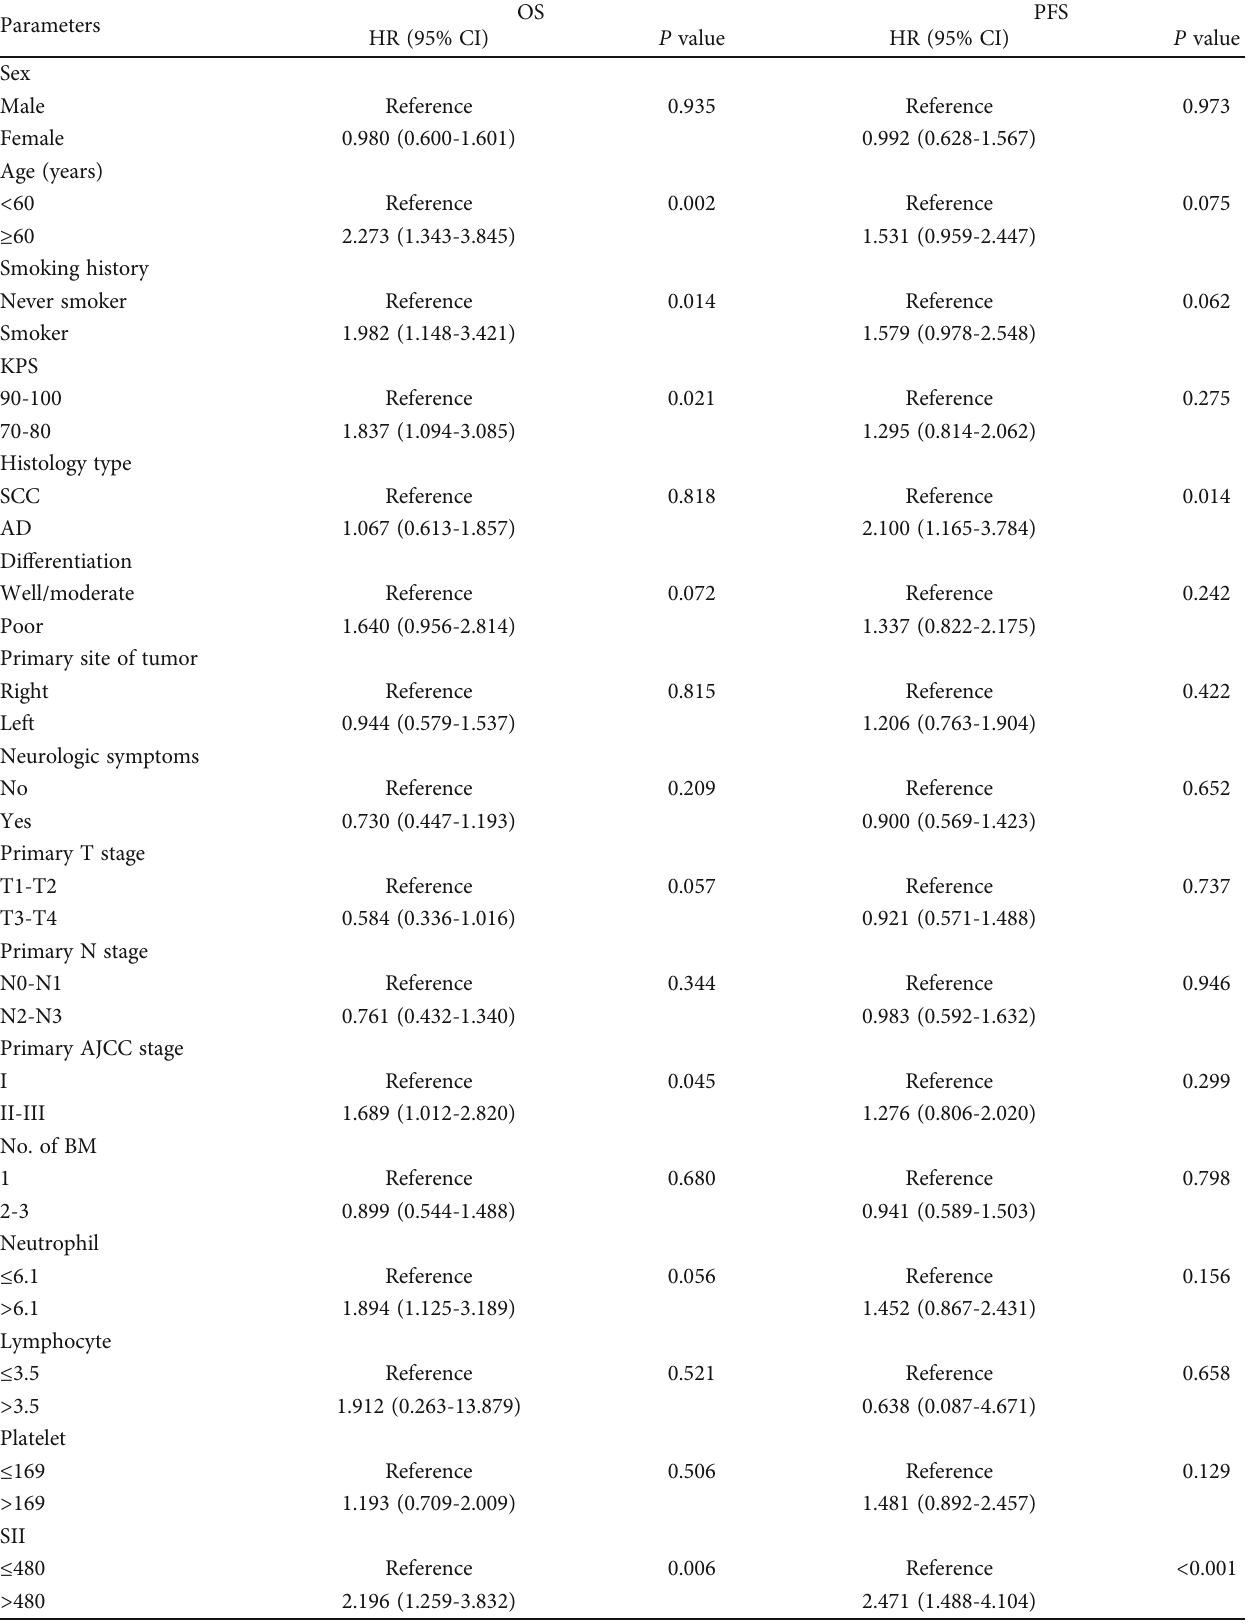
Table 3: Univariate Cox regression analyses of the SII for OS and PFS in NSCLC patients with